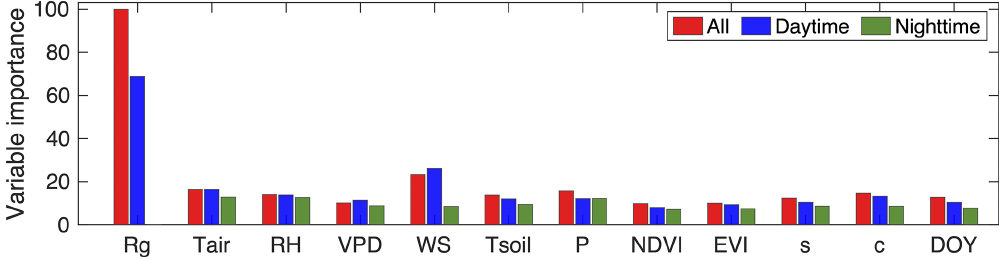
Figure 1. Variable importance for the random forest trained without separating the daytime and nighttime data (All) and separately for daytime and nighttime data. The variables DOY, c , and s indicate decimal day of year and cosine and sine functions,